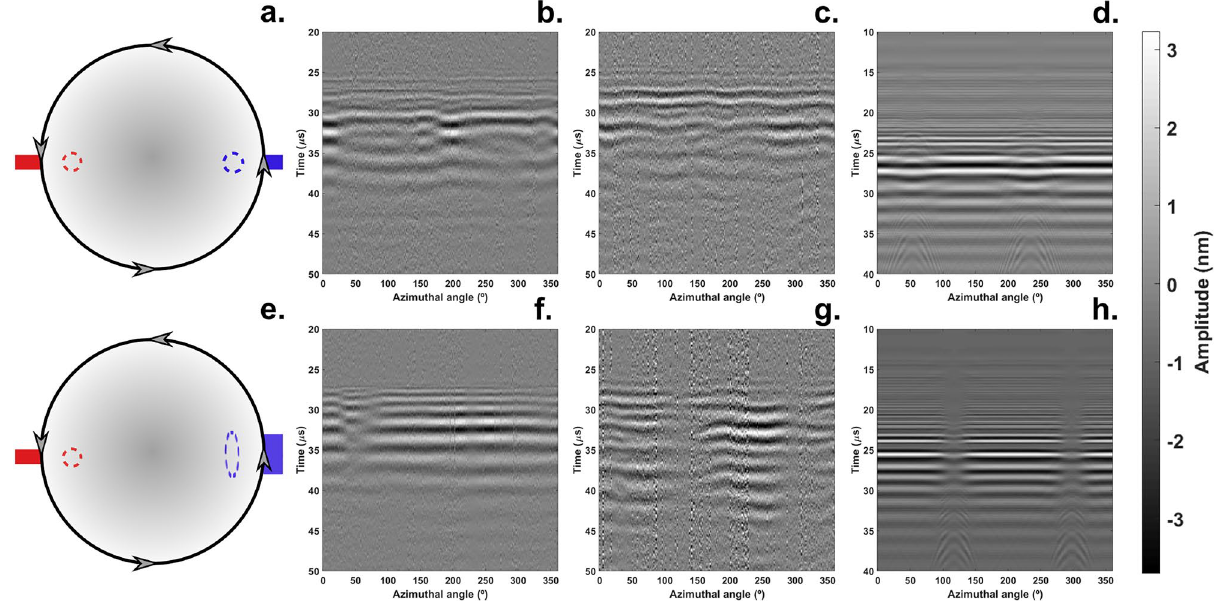
Figure 4. Detection of Lamb waves originated at the equator of the hemisphere. The Nd:YAG laser (dashed blue ellipse) generated acoustic waves from the edge of the hemisphere and the LDV aimed at the opposite end (dashed red circle) measured the vibrations ( a , e ). The acoustic maps consist of 200 signals stacked next to each other where the x-axis represents the azimuthal angle, the y-axis the propagation time of the acoustic waves and the color gradient the wave amplitude. Upper row: Lamb waves generated with a point laser source; Bottom row: Lamb waves generated with a laser line source. Intact sample ( b,f ); damaged sample with a 9.5 mm pit, experimental results ( c,g ) and FEM simulations ( d,h ). Data have been filtered to remove resonances. The laser line source produces a planar wave front whose shadowing ( g,h ) highlights the presence of a defect. In this configuration, there are insufficient data for calculating the polar angles since the echoes emanating from the defect are not visible in the experimental context ( g